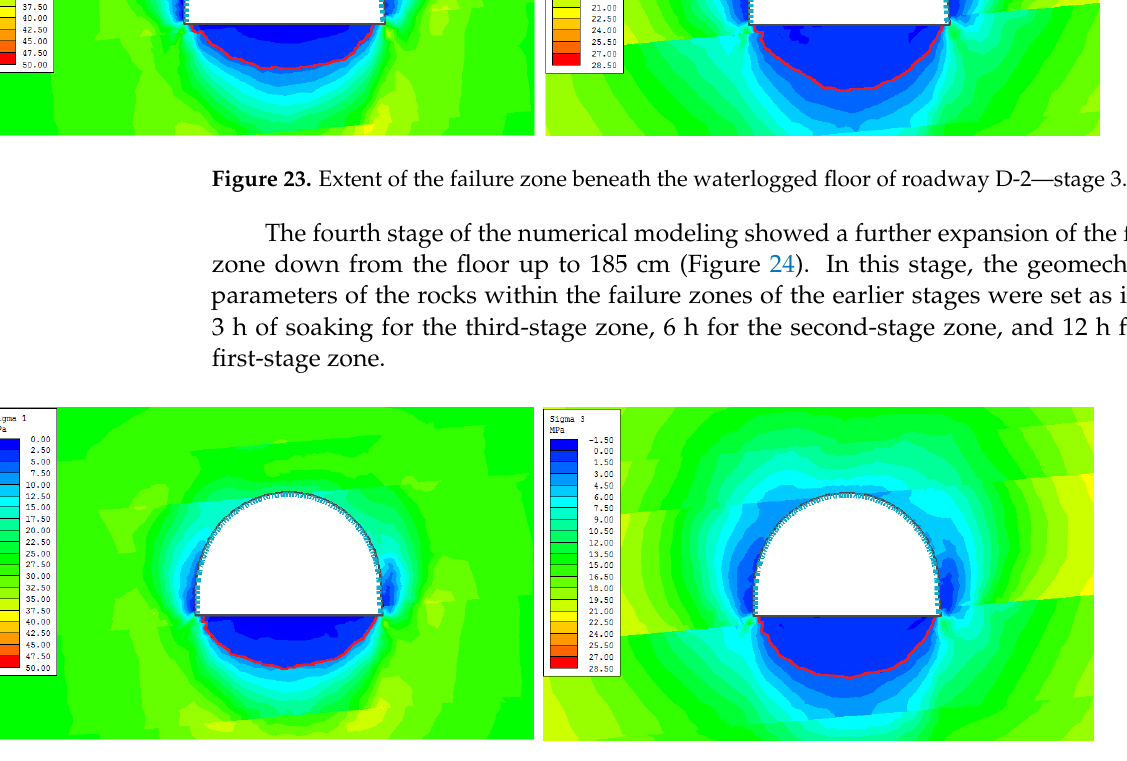
Figure 24. Extent of the failure zone beneath the waterlogged floor of roadway D-2 — stage 4.